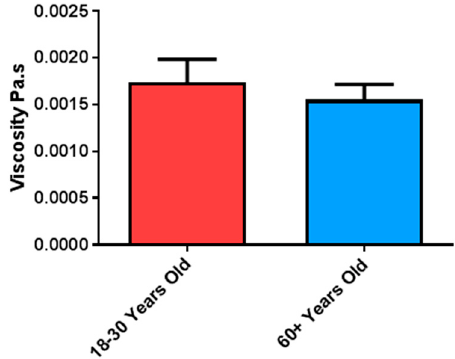
Figure 1. Mean ( +/ − SEM) dynamic viscosity of unstimulated whole mouth saliva (UWS) from older Figure 1. Mean (+/ ₋ SEM) dynamic viscosity of unstimulated whole mouth saliva (UWS) from older ( n = 24) and younger ( n = 30) subjects, determined using dynamic di ff erential microscopy ( n = 24) and younger ( n = 30) subjects, determined using dynamic differential microscopy (DDM).